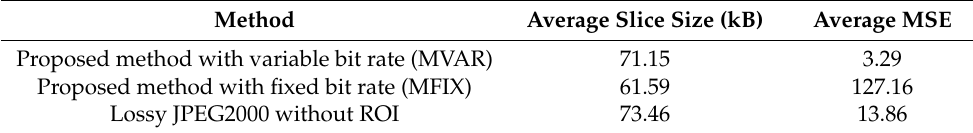
Table 3. Average slice size and Global MSE across the full 10 CTA dataset.